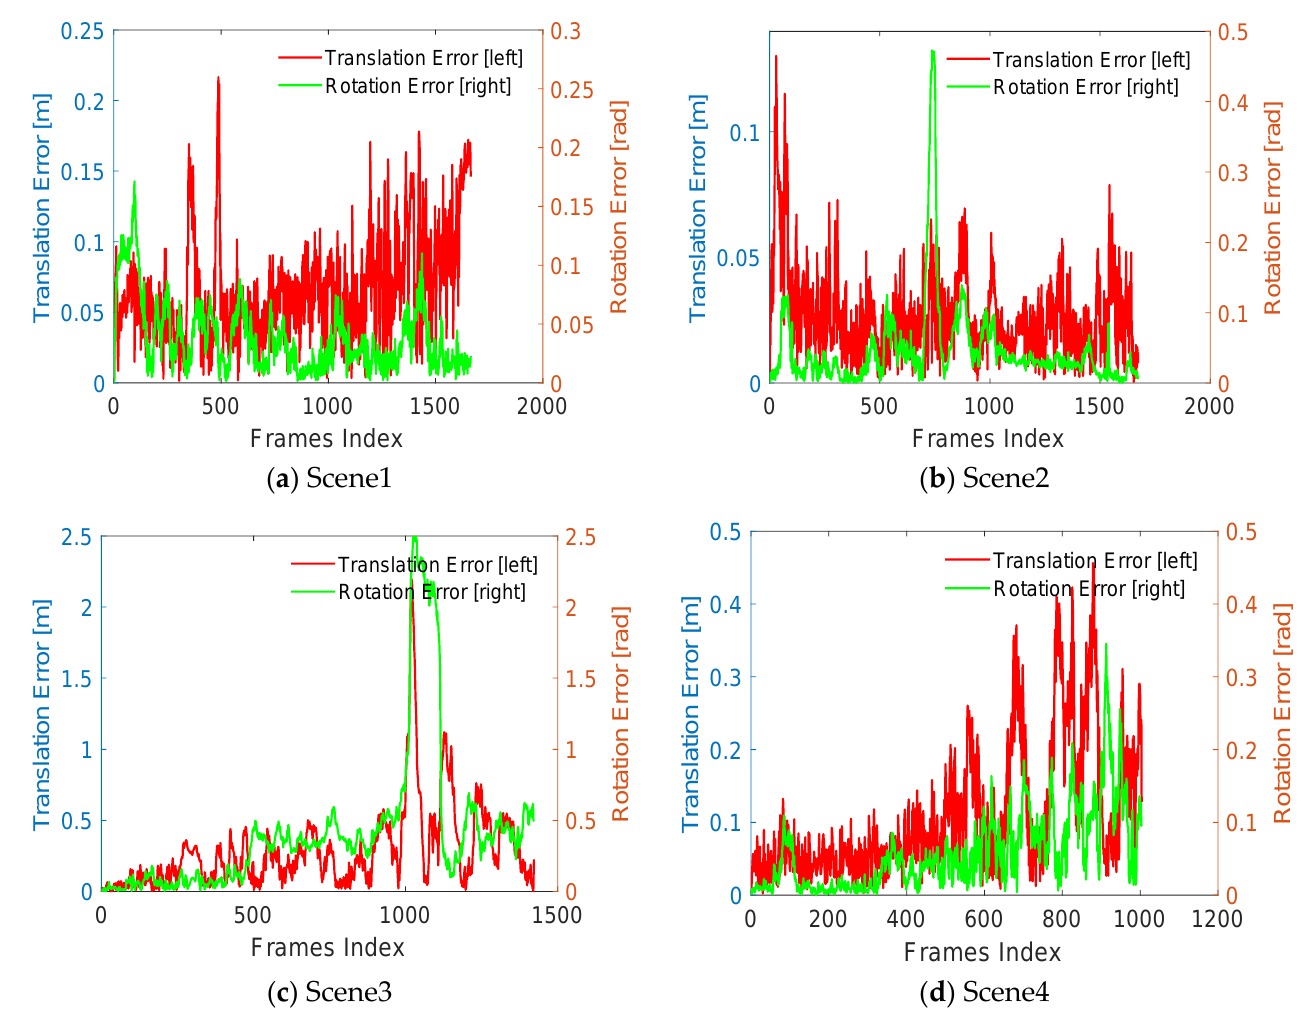
Figure 14. Localization error curve of the four underground roadway scenes. Table 1. Process time of each module in Scene 1 and Scene